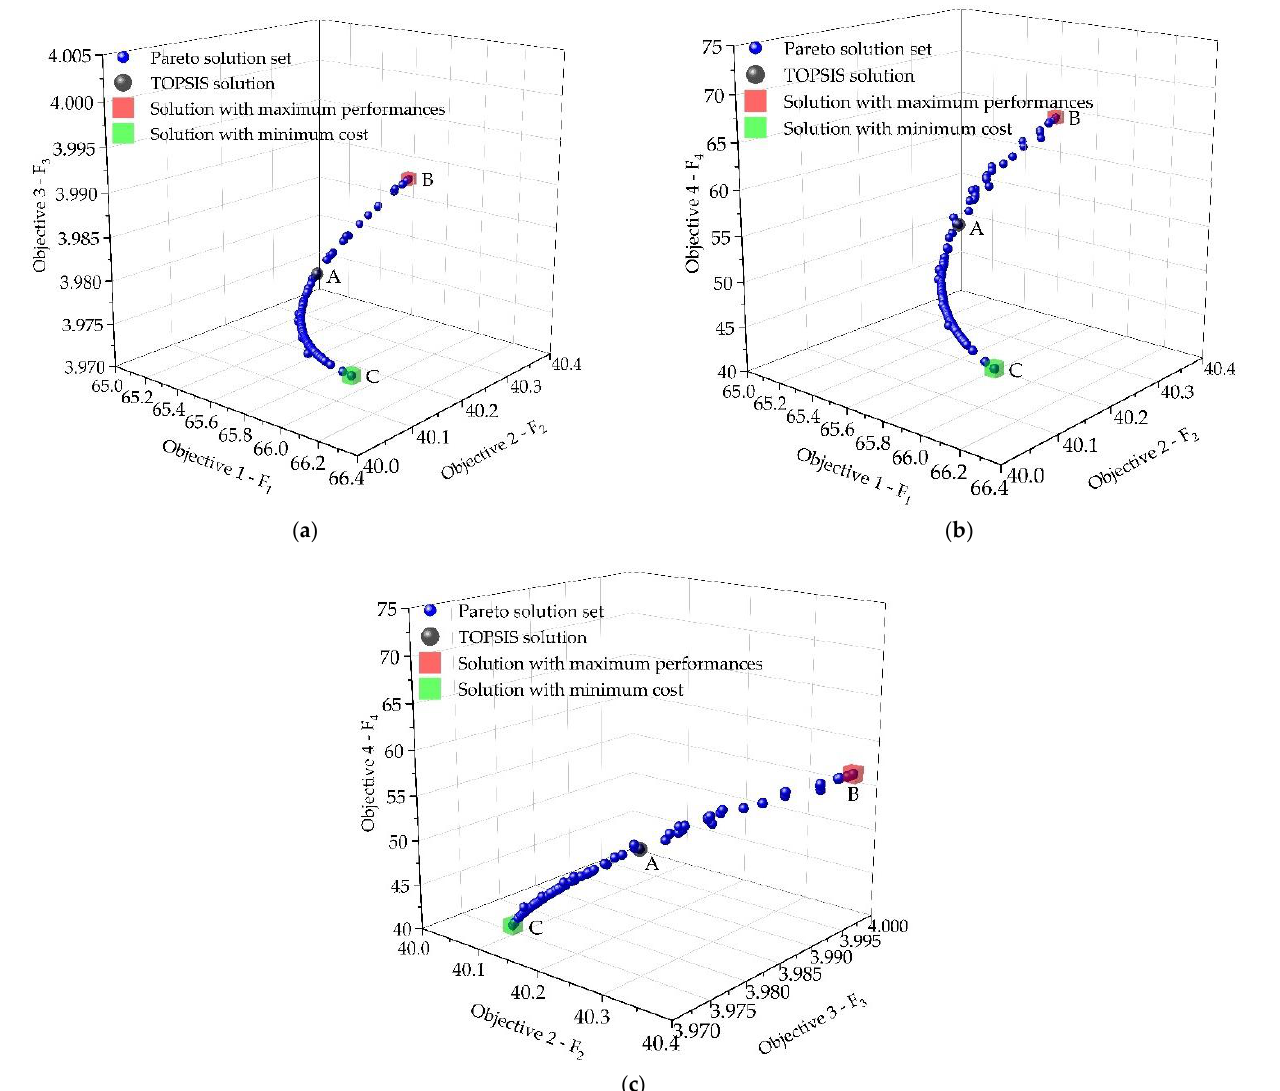
Table 11. Comparison of optimization results among the traditional orthogonal design [53], traditional MOPSO, MADS and GPR-AWMOPSO algorithm.